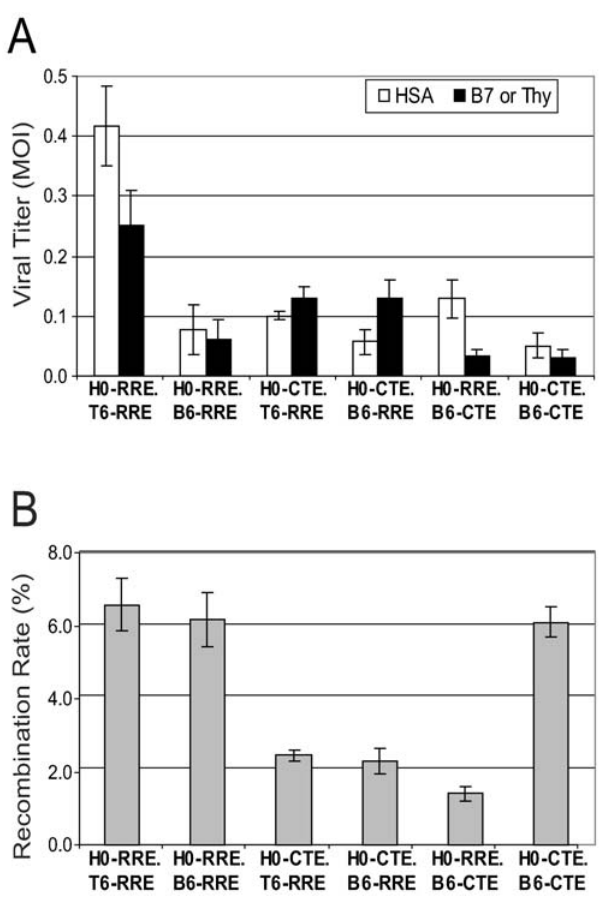
Figure 3. Effect of nuclear export pathway on recombination. (A) Titers of the HSA and Thy, or HSA and B7 viruses generated from producer cell lines. White bars represent titers of viruses encoding HSA, whereas black bars represent titers of viruses encoding Thy or B7, respectively. (B) Observed recombination rates using viruses from each cell line. Means and standard deviations generated from three experiments are shown.